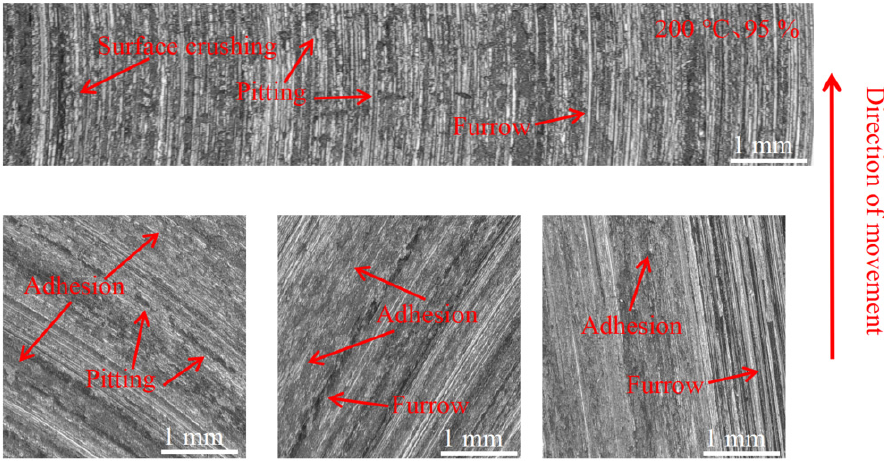
◦ C and 95% ambient